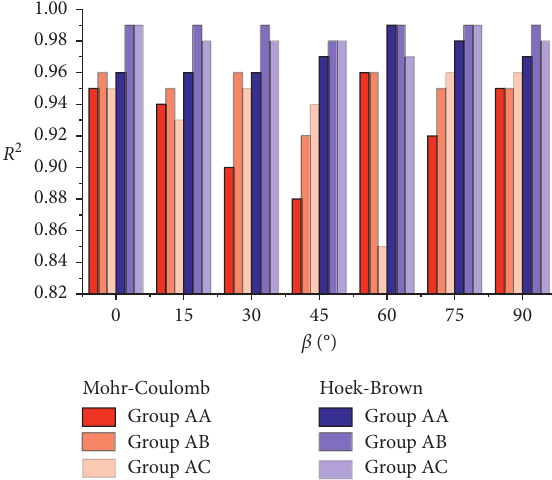
Figure 14: Error analysis of the fitting results using the two strength